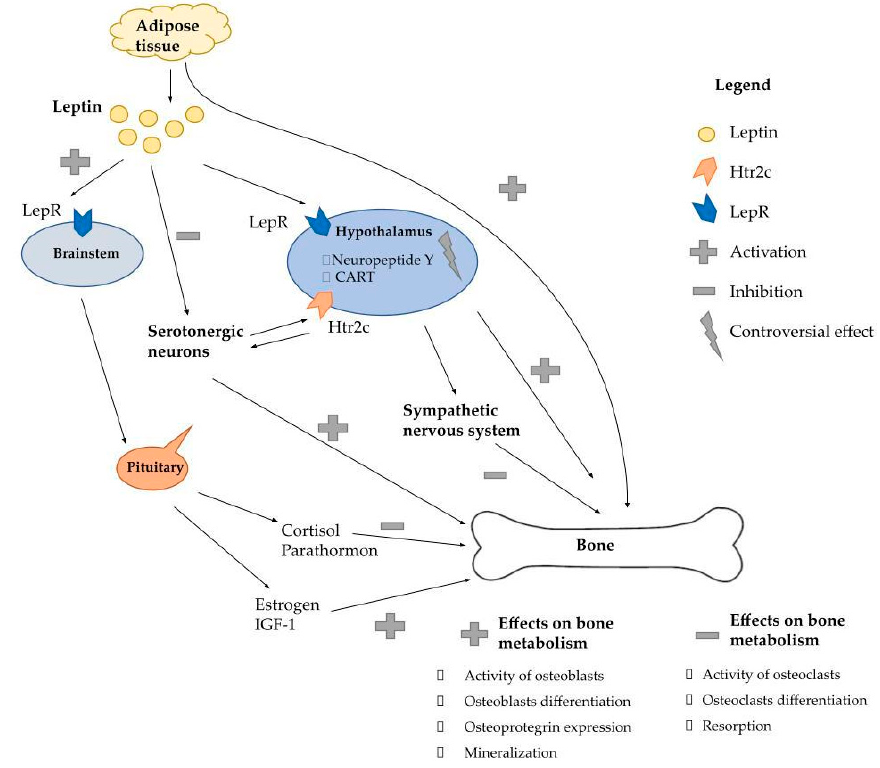
Figure 1. The multidirectional effect of leptin on bone metabolism. Lepr—leptin receptor; Htr2c— 5-hydroxytryptamine receptor 2c; CART—cocaine- and amphetamine-regulated transcript; IGF1—